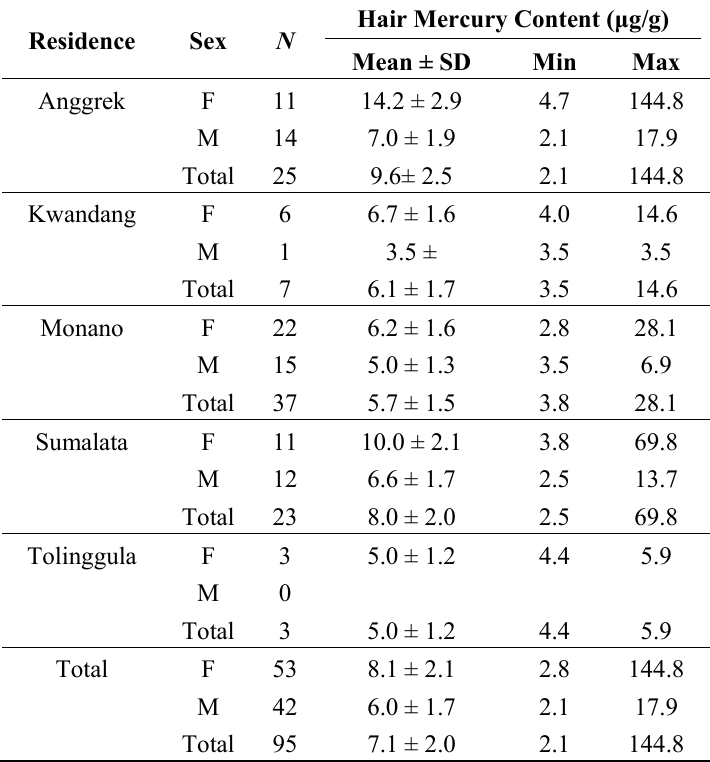
Table 1. Geometrical mean, standard deviation and range of hair mercury content of inhabitants of Gorontalo Utara